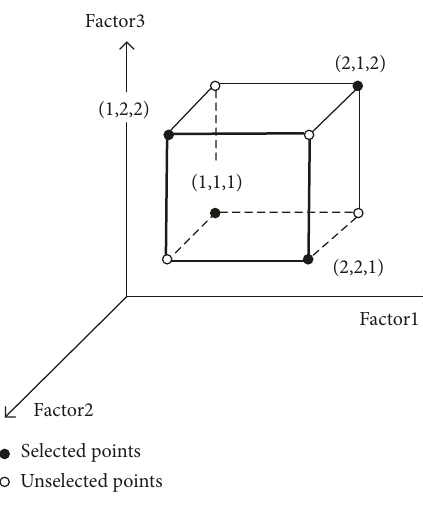
Figure 2: Space model of L 4 (2 3